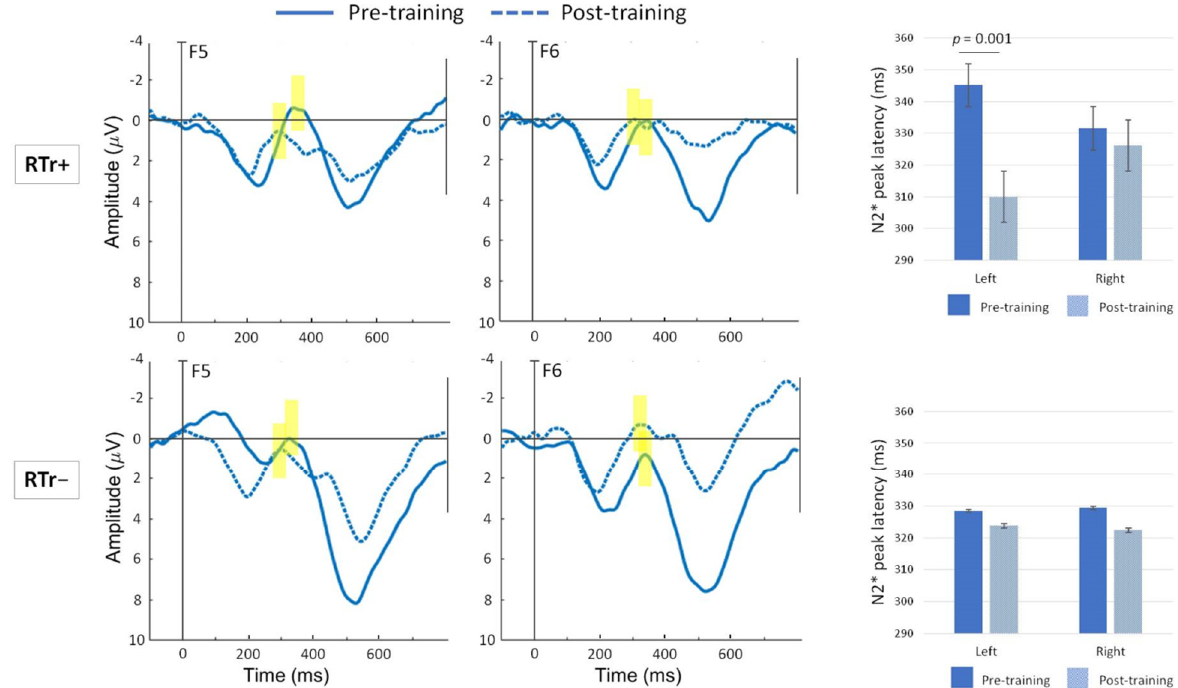
Figure 5. Grand average waveforms are shown for the DEVD condition, where the N2* peak is maximal. The pre-training waveform (solid line) is plotted against the post-training waveform (dotted line) for RTr+ and RTr − infants. Representative channels F5 and F6 located, respectively, in the left and right frontocentral regions are shown. Highlighted yellow bars indicate the location of the maximum N2* peak. Plots were filtered using a 20 Hz low-pass filter for presentation purposes only. Negative voltage is plotted upward. On the right, bar graphs (error bars indicate SEM) show the mean N2* peak latency.